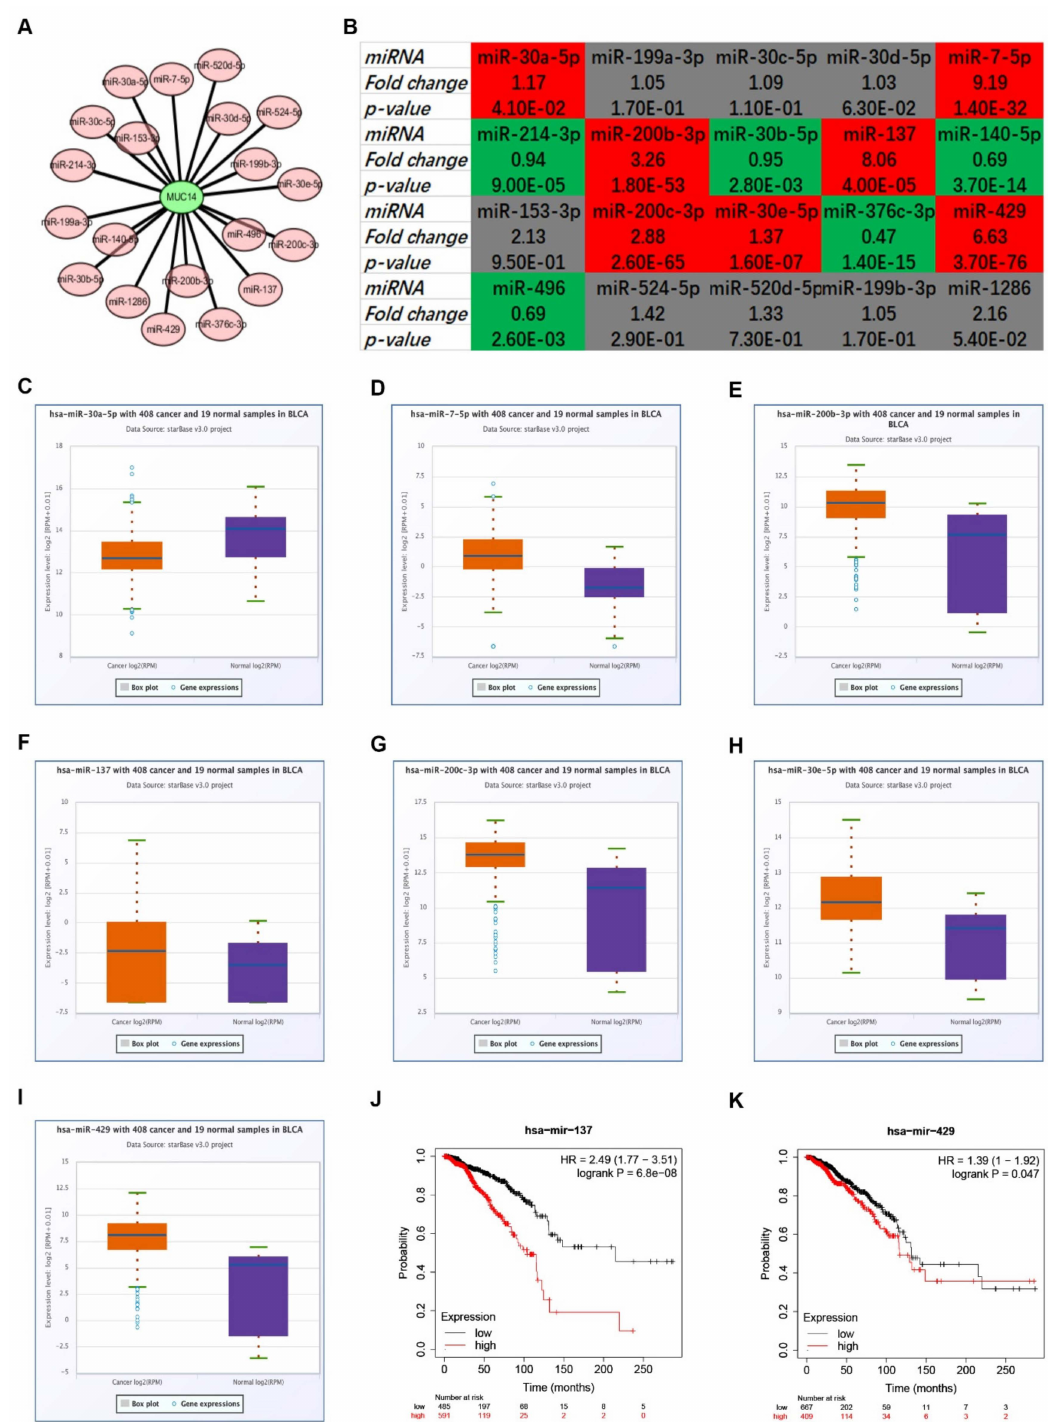
Figure 5. The potential upstream miRNAs of MUC14 in breast cancer. ( A ) A MUC14-miRNA regulatory network. ( B ) The expression landscape of 20 predicted miRNAs of MUC14 in breast cancer. The expression of miR-30a-5p ( C ), miR-7-5p ( D ), miR-200b-3p ( E ), miR-137 ( F ), miR-200c-3p ( G ), miR-30e-5p ( H ) and miR-429 ( I ) in breast cancer. ( J ) The prognostic value of miR-137 in breast cancer. ( K ) The prognostic value of miR-429 in breast cancer. “ p < 0.05” was considered as statistically